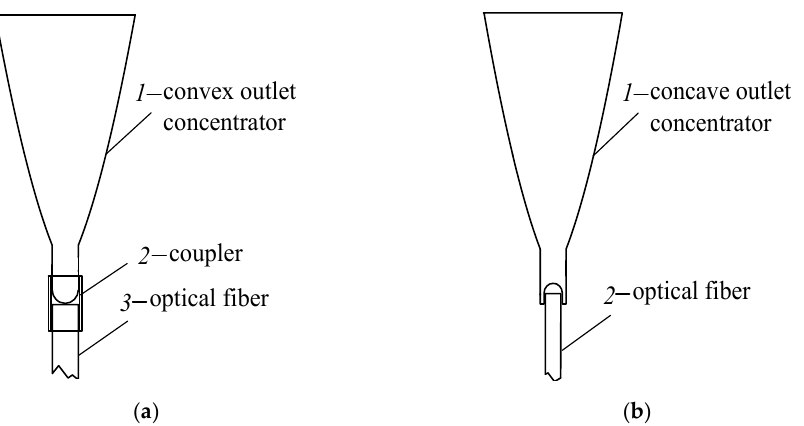
Figure 1. ( a ) Receiving unit with a convex outlet concentrator. ( b ) Receiving unit with a concave outlet concentrator.